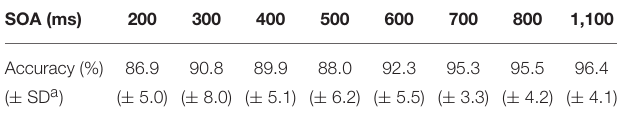
TABLE 1 | Averaged button-press accuracy for eight